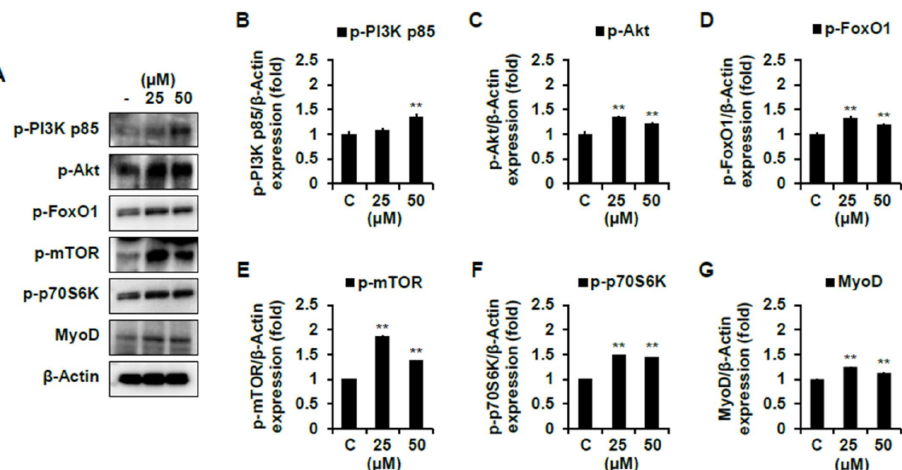
Figure 7. Skeletal muscle cell differentiation activity of compound 1 on C2C12 differentiated cells. The levels of p-PI3K p85, p-Akt, p-FoxO1, p-mTOR, p-p70S6K, and MyoD proteins were determined using a Western blot analysis. Every level of proteins versus β -Actin were measured by densitometry. C, control. Experiments were performed in triplicate and the data are expressed as mean ± SE; ** p < 0.01 as compared to the control (untreated